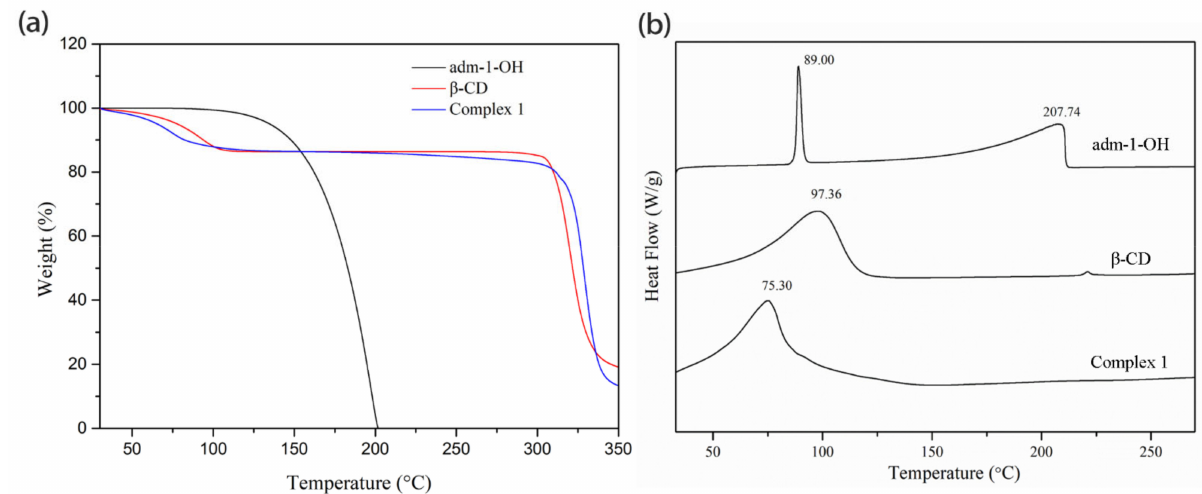
Figure 1. ( a ) TG traces of adm-1-OH, β -CD and 1 . ( b ) A comparison of the DSC-TGA curves of 1 and its subcomponents β -CD and adm-1-OH, showing the melting point alteration upon complex